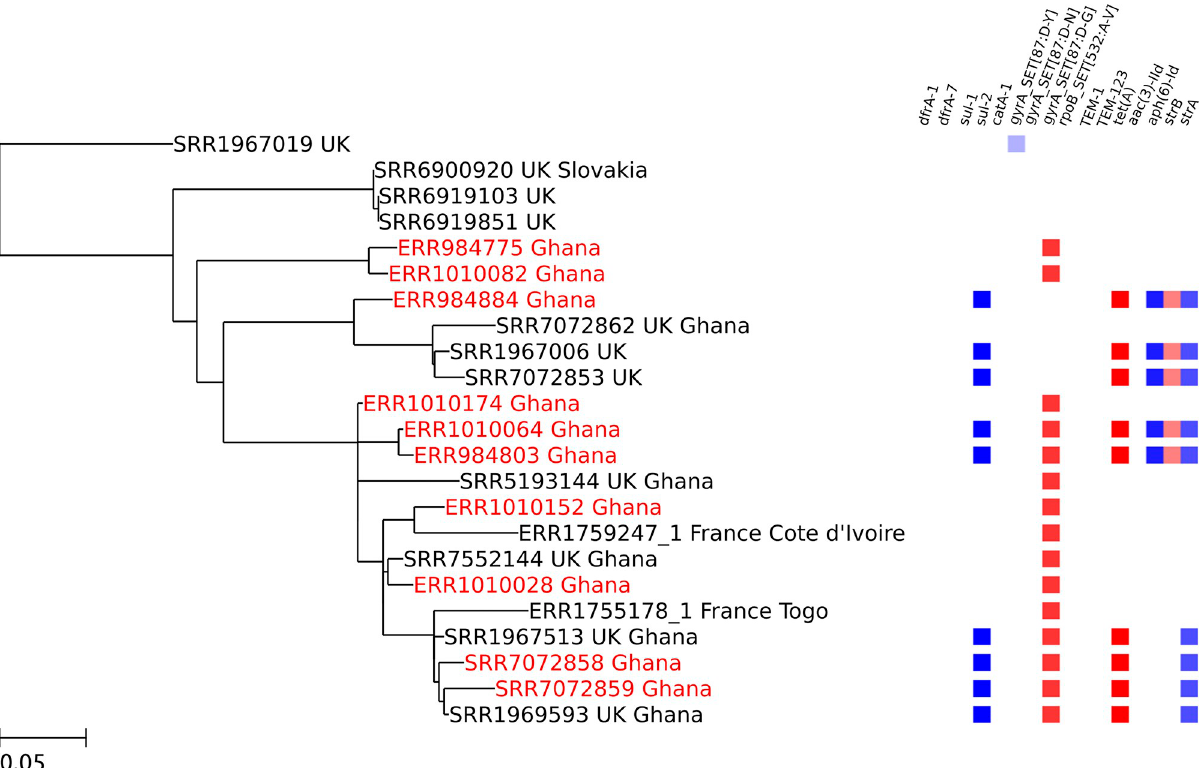
Fig 2. Zoomed-in maximum likelihood tree showing the largest monophyletic cluster of Ghanaian isolates within the global epidemic clade (Ghana clade 1). The ten Ghanaian isolates within this clade are highlighted in red (nine human bloodsteam isolates and one poultry isolate, SRR7072859). Each isolate in the tree is represented by its accession number followed by the country of origin. In the case of PHE isolates, second countries listed after the country of origin represent reported travel destinations. A heatmap showing the resistance genes present in each isolate (the gyrA 87:D-G mutation is shown as a red box) is displayed on the right. The scale bar shows nucleotide substitutions per site.